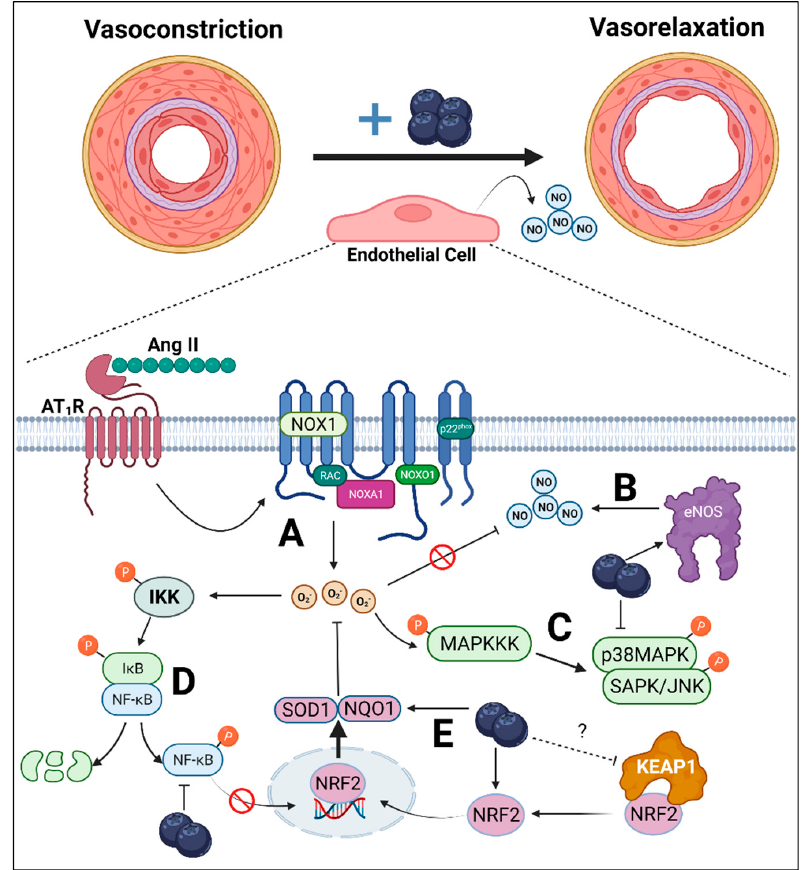
Figure 6. Overall endothelial-dependent mechanisms by which blueberry polyphenols may attenu- ate hypertension. Upregulated renin – angiotensin – aldosterone system results in the increased syn- hypertension. Upregulated renin–angiotensin–aldosterone system results in the increased synthesis of angiotensin (Ang) II, which causes vasoconstriction due to reduced endothelial-derived